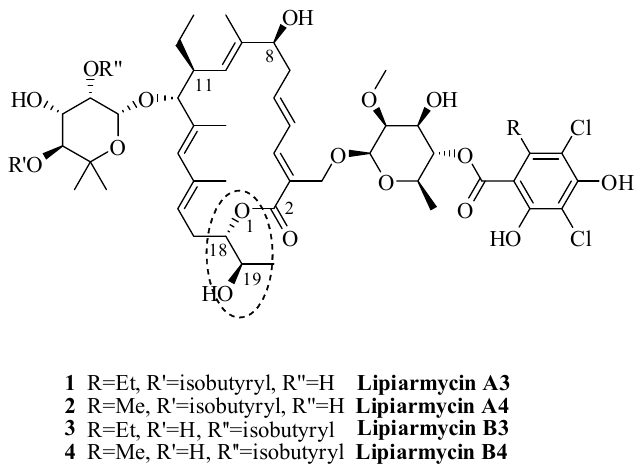
Figure 1. Chemical structures of lipiarmycins.